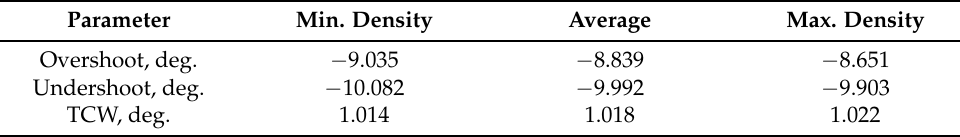
Table 3. Effect of density variations on Mars aerocapture